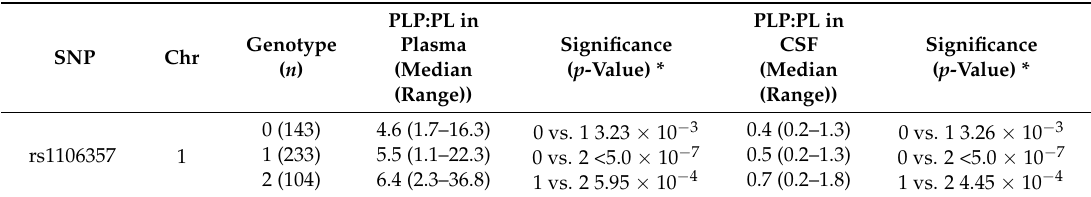
Table 3. Relation between genotype and phenotype for the genome-wide significant locus. Only phenotypes with the highest weight for each genotype are